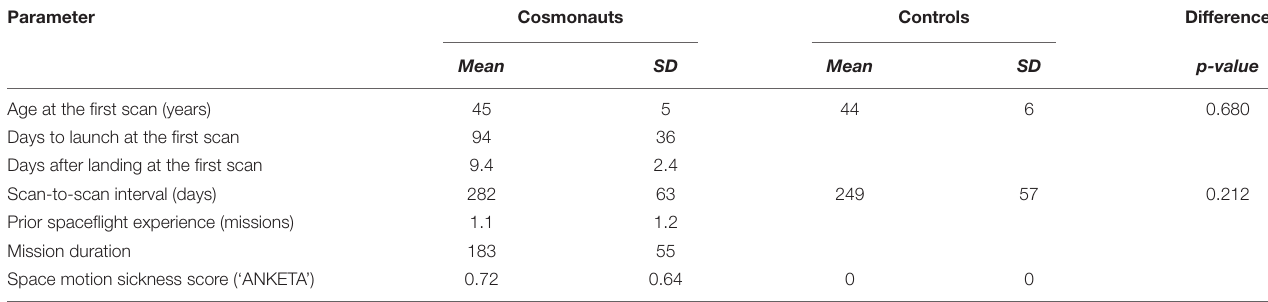
TABLE 1 | General demographics, spaceflight-related information, and scan-to-scan intervals for the cosmonauts and control participants. Parameter